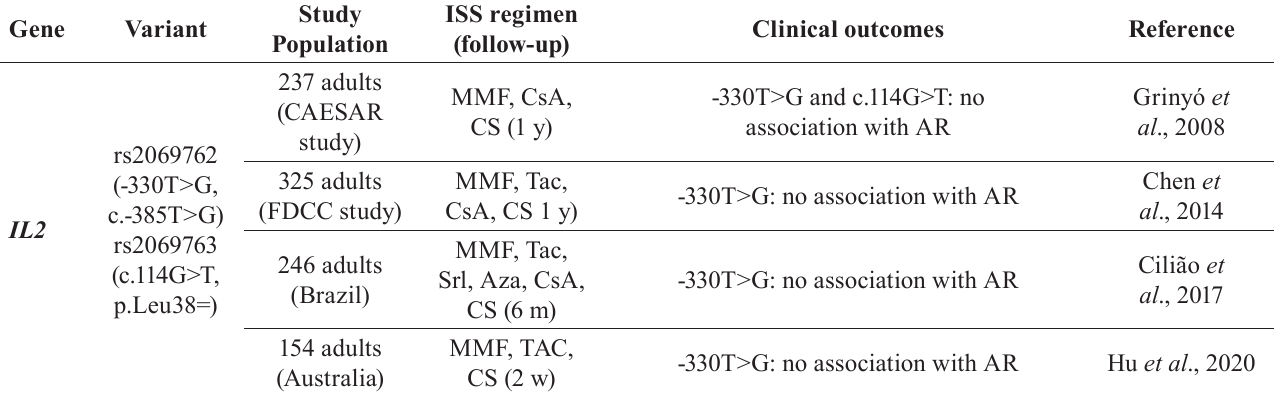
TABLE IV - Genes related to pro-inflammatory cytokines in kidney recipients on MPA therapy without significant associations Gene